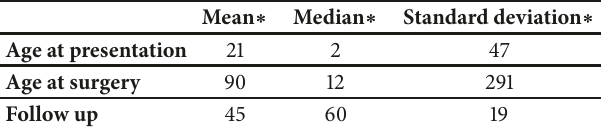
Table 2: Measured demographic variables.